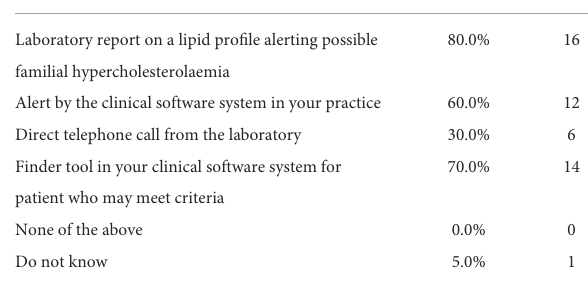
TABLE 2 Tools to assist in detection of